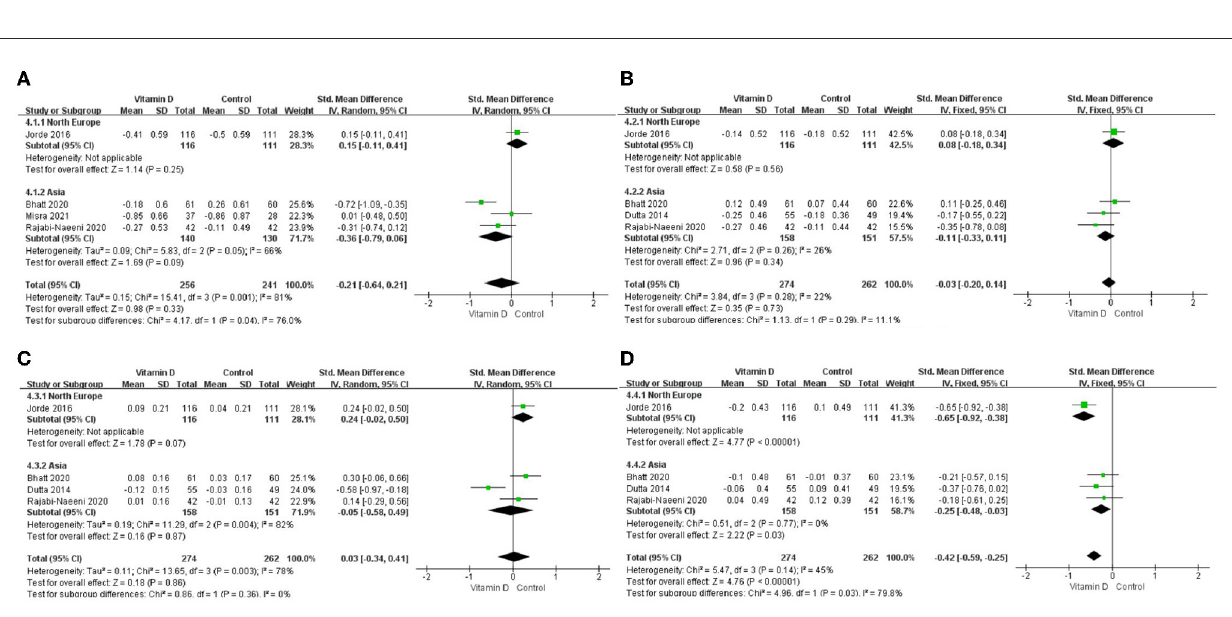
be extrapolated to other regions or ethnicity subgroups, and relative trials in more regions are